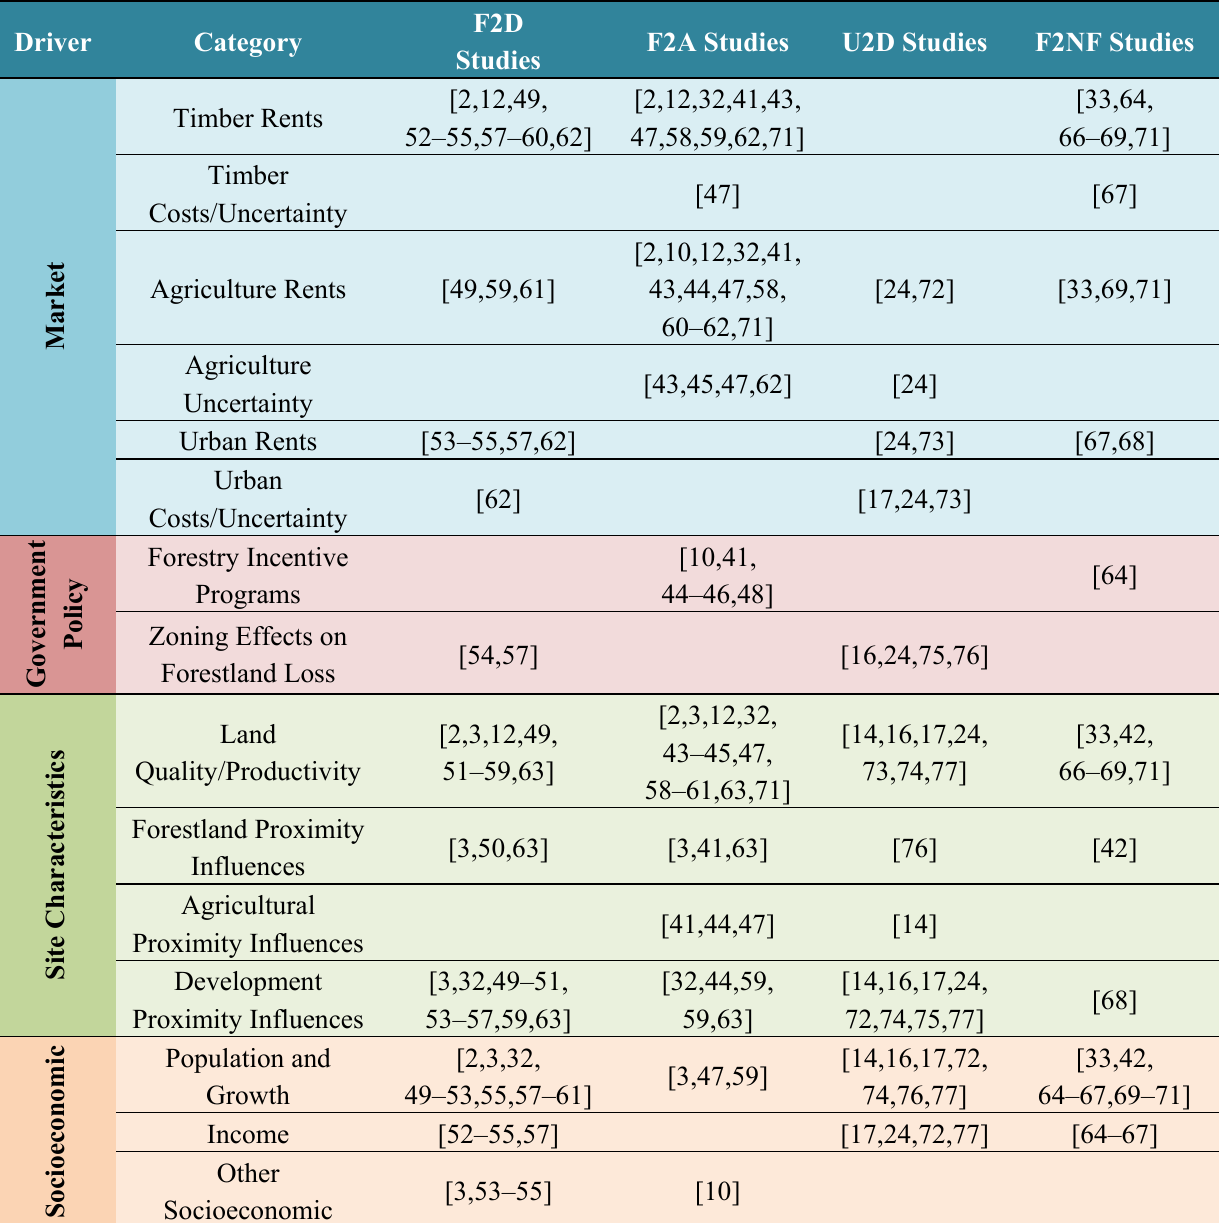
Table 5. Suggested econometric studies that contained successful predictive independent variables in four forestland loss model types. Studies are identified by citation number and organized by major econometric drivers and categories of independent variable